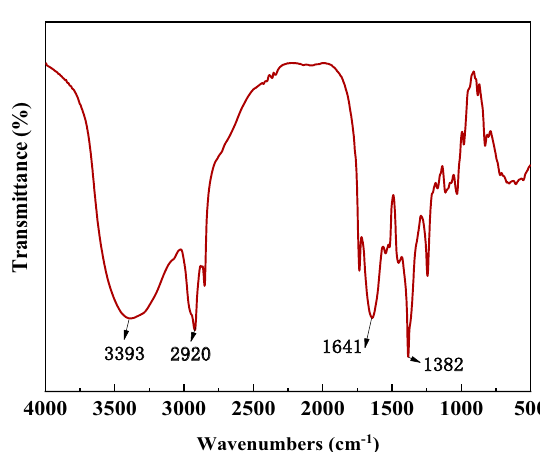
Fig. 12 FTIR of the Broussonetia papyrifera